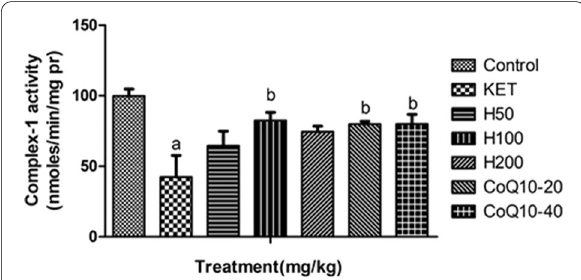
Fig. 14 Effect of hesperidin and Coenzyme Q10 on complex II enzyme activity in the hippocampus region of the brain. Data were analyzed by one-way ANOVA followed by Tukey’s post hoc analysis. All values were expressed as Mean SEM. a p < 0.05 as compared ± to naive, b p < 0.05 as compared to ketamine. KET, Ketamine, H, Hesperidin, CoQ10, Coenzyme